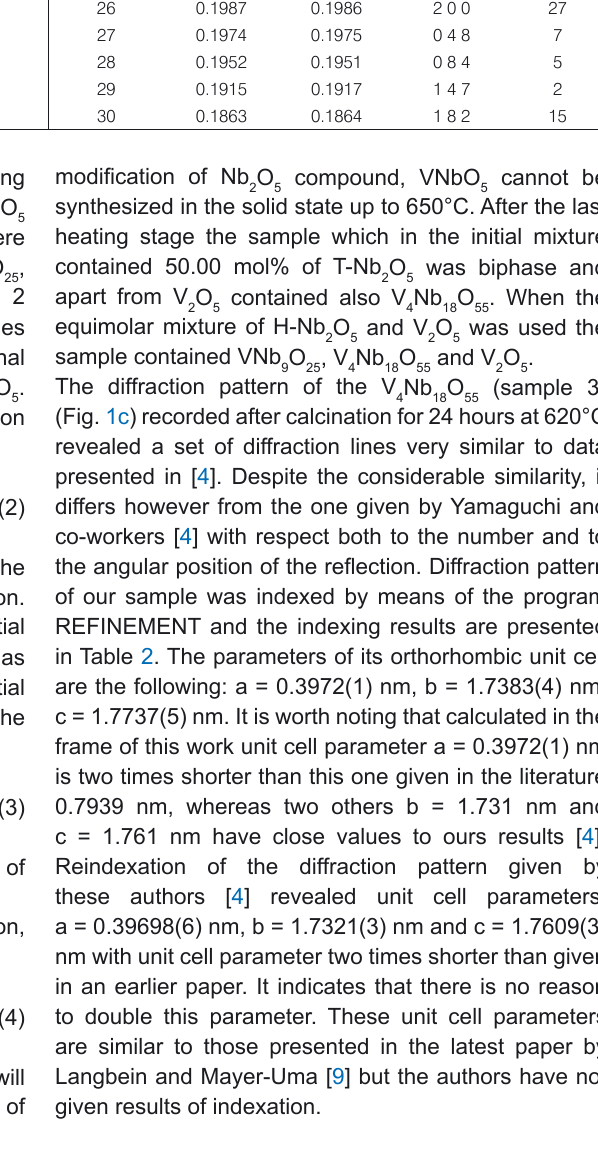
powder diffraction pattern